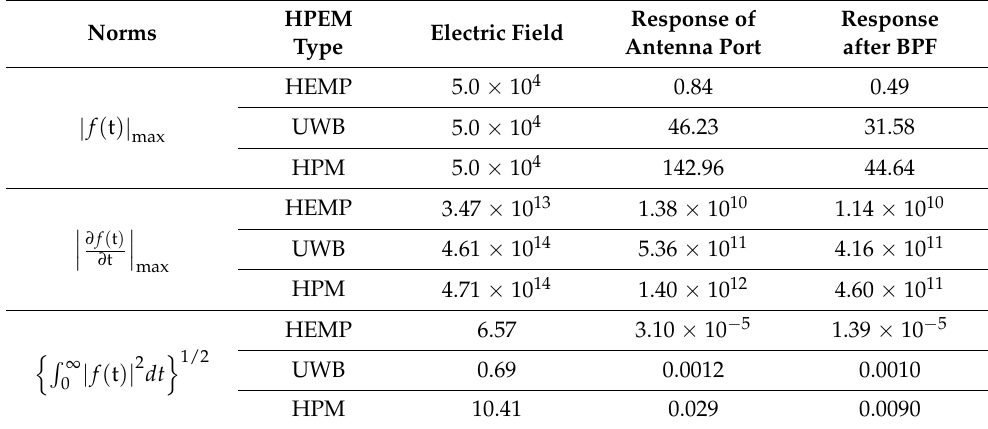
Table 2. Norm results of the HPEM and the responses.